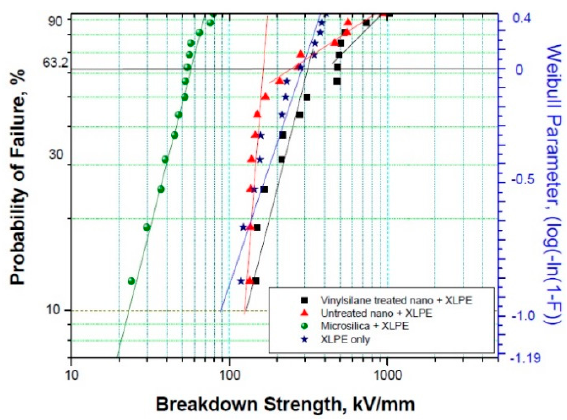
Figure 33. Weibull plot for the electrical breakdown strength of XLPE with 5 wt % micro-/untreated and vinylsilane-treated nanoSiO 2 at 25 °C (© 2016 IEEE. Reprinted, with permission, from